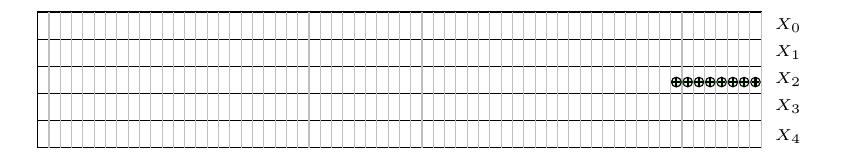
Figure 3: Addition of constant in word X 2 of